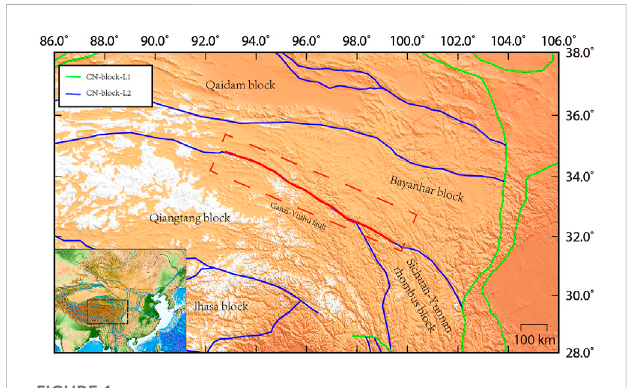
Tectonic map of Ganzi-Yushu fault zone. The red line is the Ganzi- Yushu